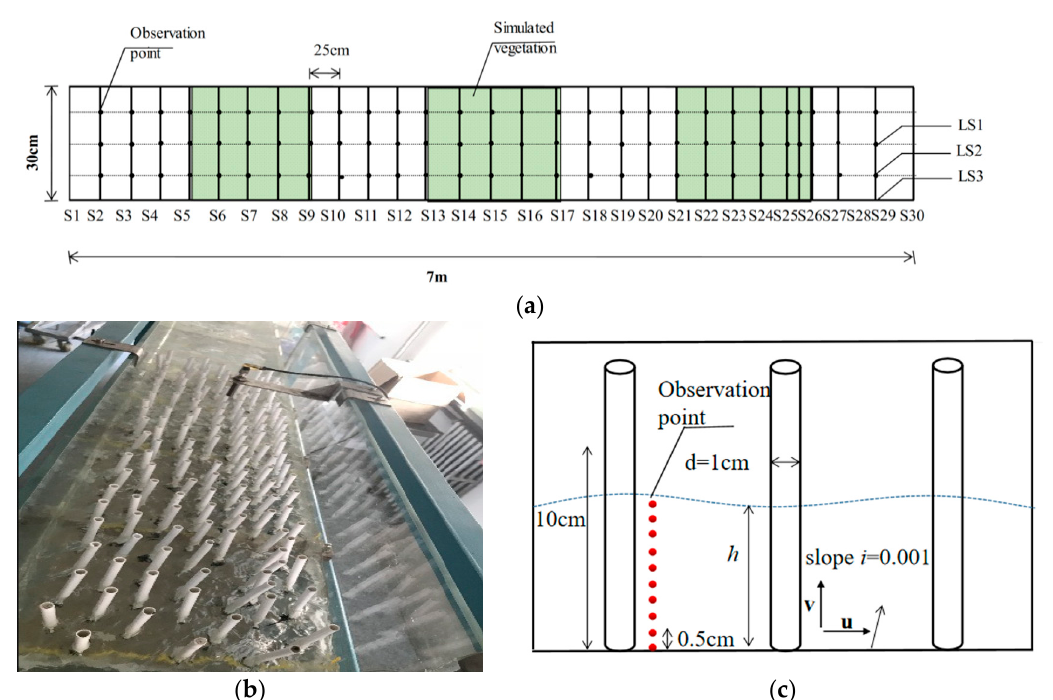
Figure 3. Locations of measurement points: ( a ) Measured points along the flow direction in plan view; ( b ) Artificial plants and measuring instruments; ( c ) Measurement points along the water depth.